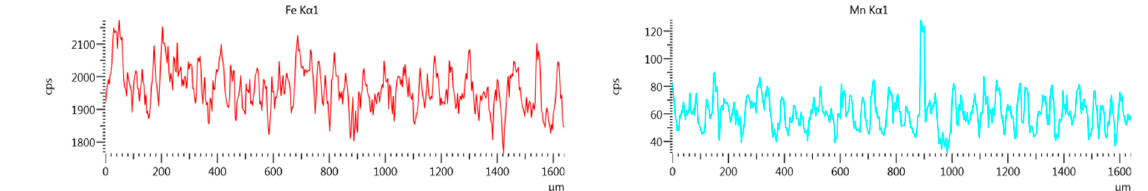
Figure 19. Ferrite and manganese amount along the overlap transition measurement line.